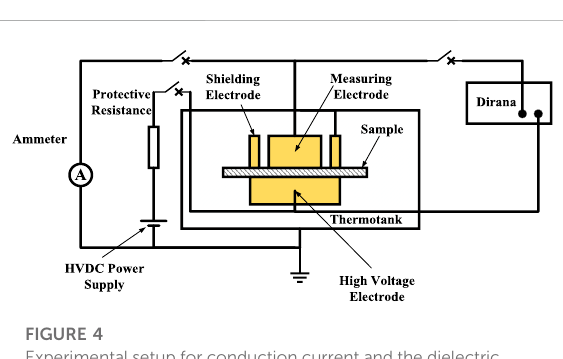
FIGURE 4 Experimental setup for conduction current and the dielectric